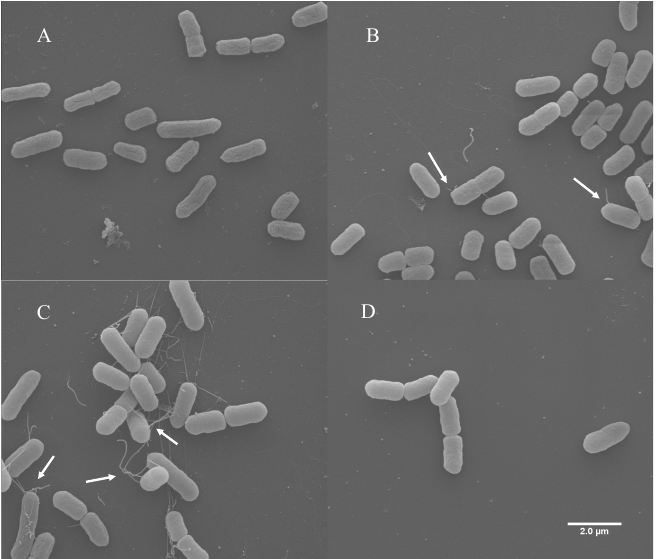
Figure 5. Scanning electron microscopy images. ( A ) PA20 pSE380; ( B ) PA20 pSE380 exposed to 20 mM sodium butyrate; ( C ) PA20 pSE380:: pchE ; and ( D ) PA20 ∆ fliC pSE380:: pchE grown in EMEM at 37 ◦ C. The arrows indicate